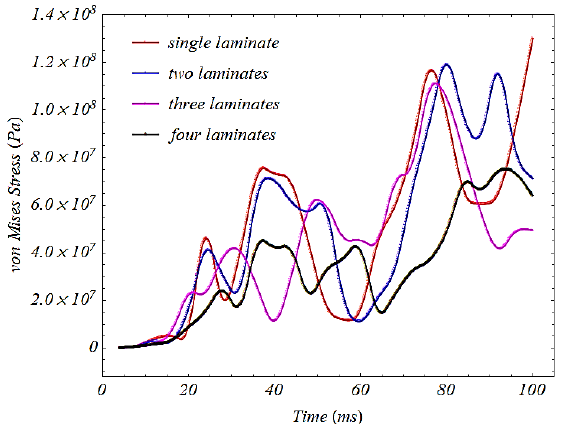
Fig. 16. von Mises stress against time for various number of cellphone casing laminates at 500 mm drop distance.